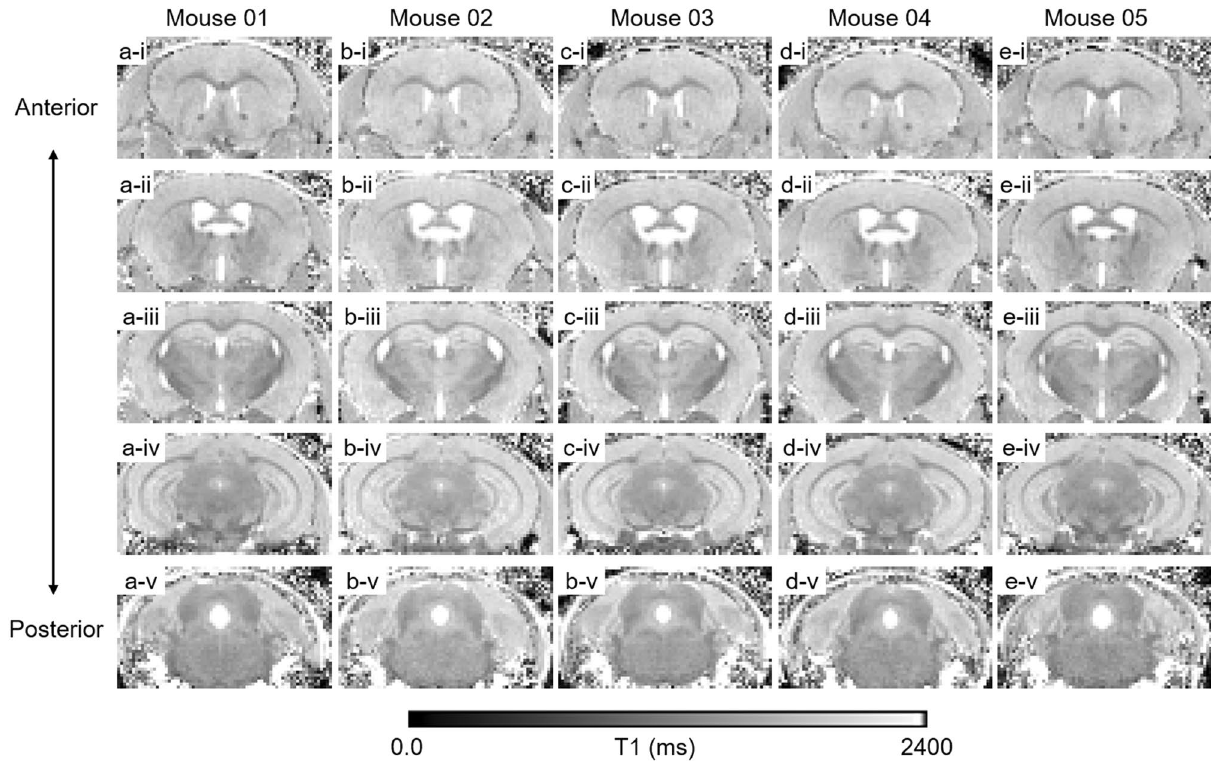
Figure 2. MP2RAGE-based T1 MRI maps from 5 control mice at 160 µm isotropic spatial resolution in vivo. ( a – e ) Each column represents an individual mouse. Row i. Anterior coronal slices at the level of the genu of the corpus callosum. Row ii. Anterior coronal slices at the level of the hippocampal commissure. Row iii. Coronal slices at the level of the anterior hippocampus. Row iv. Coronal slices at the level of the posterior hippocampus. Row v. Posterior coronal slices at the level of the 4th